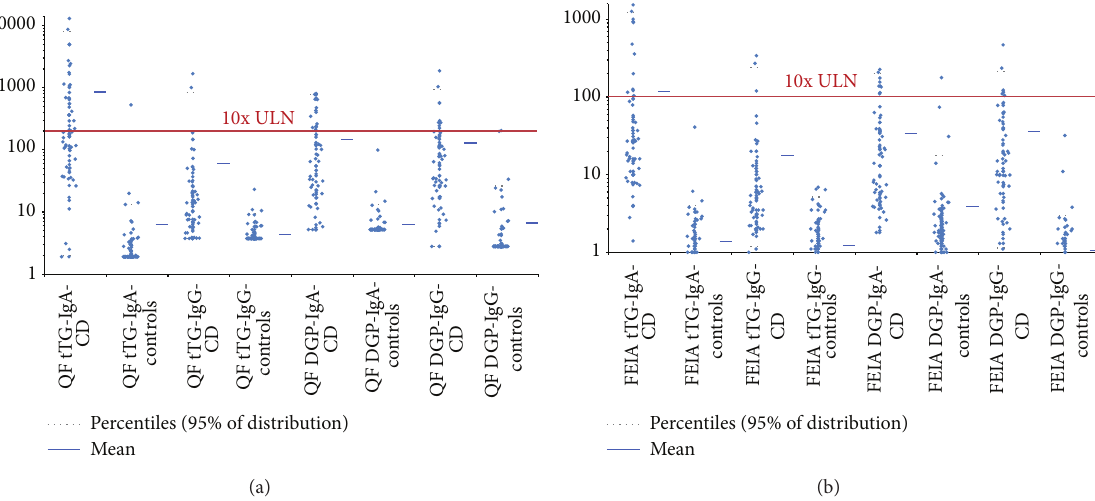
Figure 5: Comparative descriptive analysis. Antibody levels for QUANTA Flash (QF) assays in (a) and fluoroenzyme immunoassays (FEIAs) in (b). The 10 upper limit of normal is indicated by the red